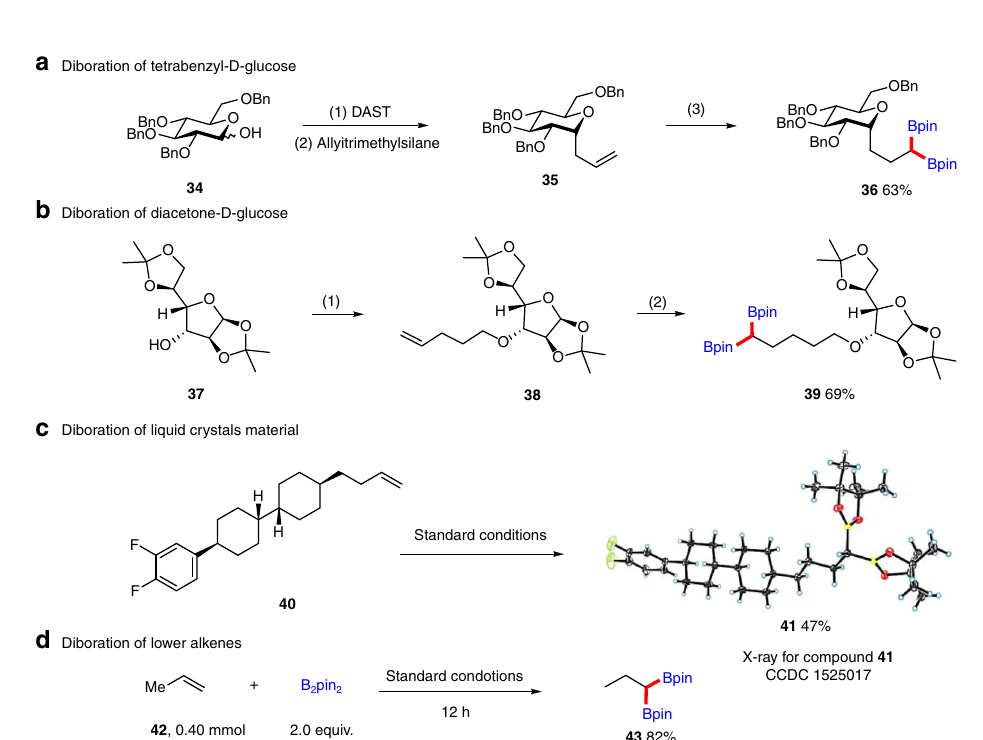
Fig. 2 1,1-Diboration of sugar derivatives, LCs and lower alkenes. a (1) DAST (diethylaminotri fl uorosulfur, 1.1 equiv.), THF, − 30 °C. (2) Allyltrimetnylsilane (2.0 equiv.), 20% BF 3 · Et 2 O, DCM. (3) 10% Ni(COD) 2 , 10% Cy-Xantphos. b (1) NaH, DMF, 5-bromopent-1-ene, 0 °C. (2) Standard conditions, 4 h. c Standard conditions. d Standard conditions, 12